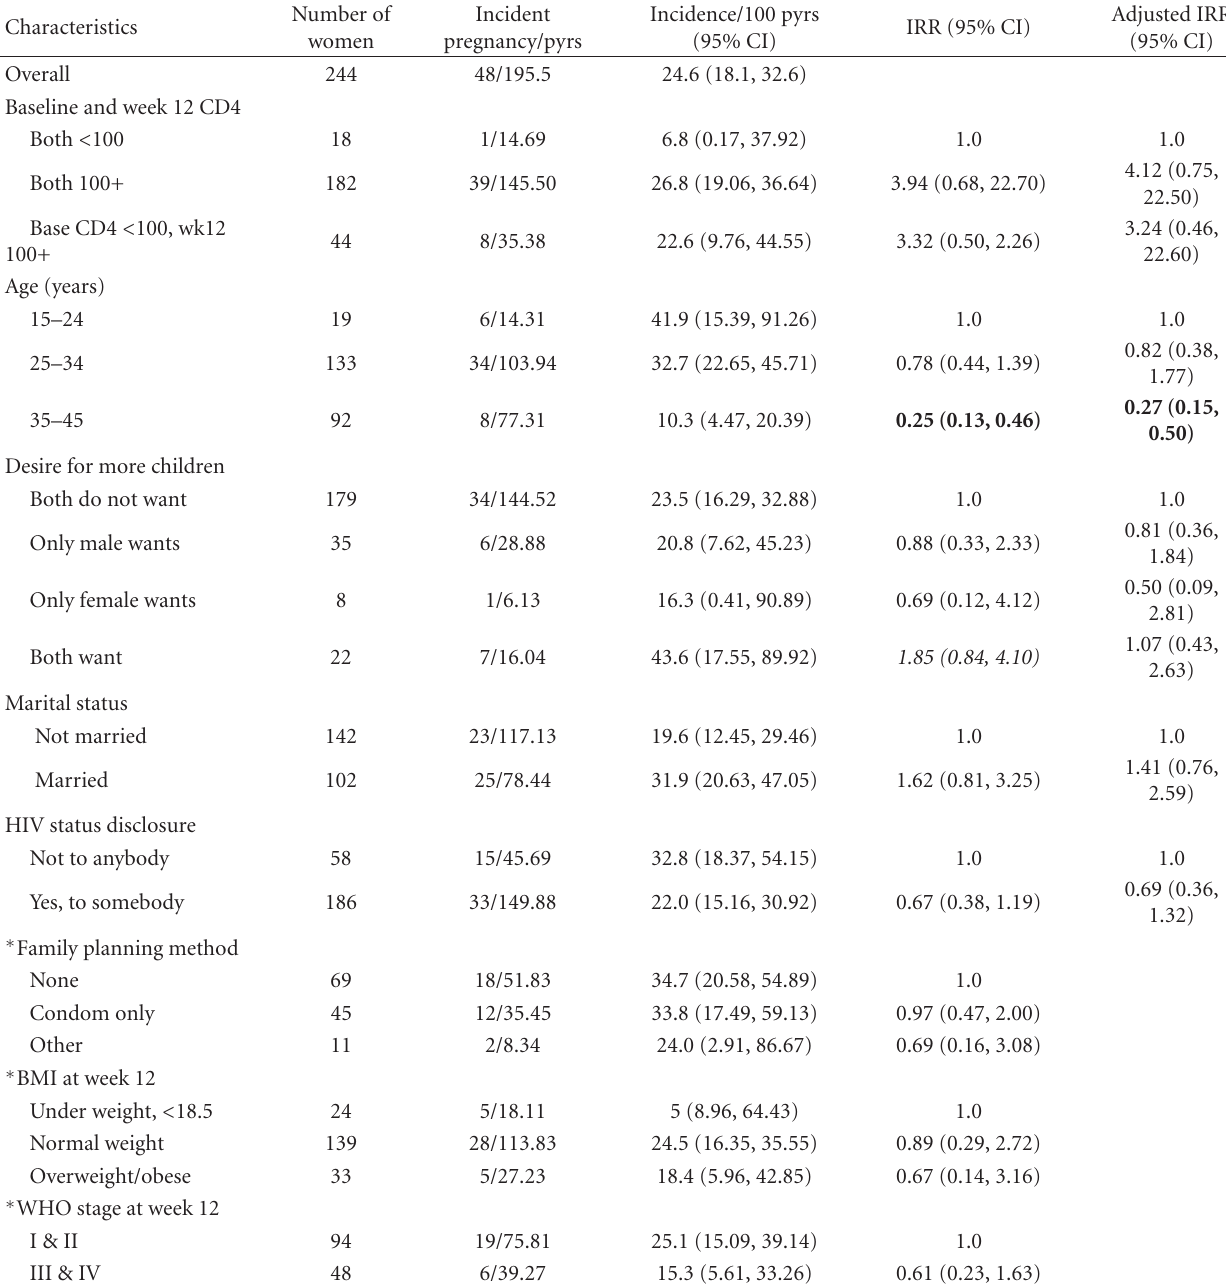
Table 5: Incidence of pregnancy, unadjusted and adjusted IRR among HIV+ women after initiating ART.